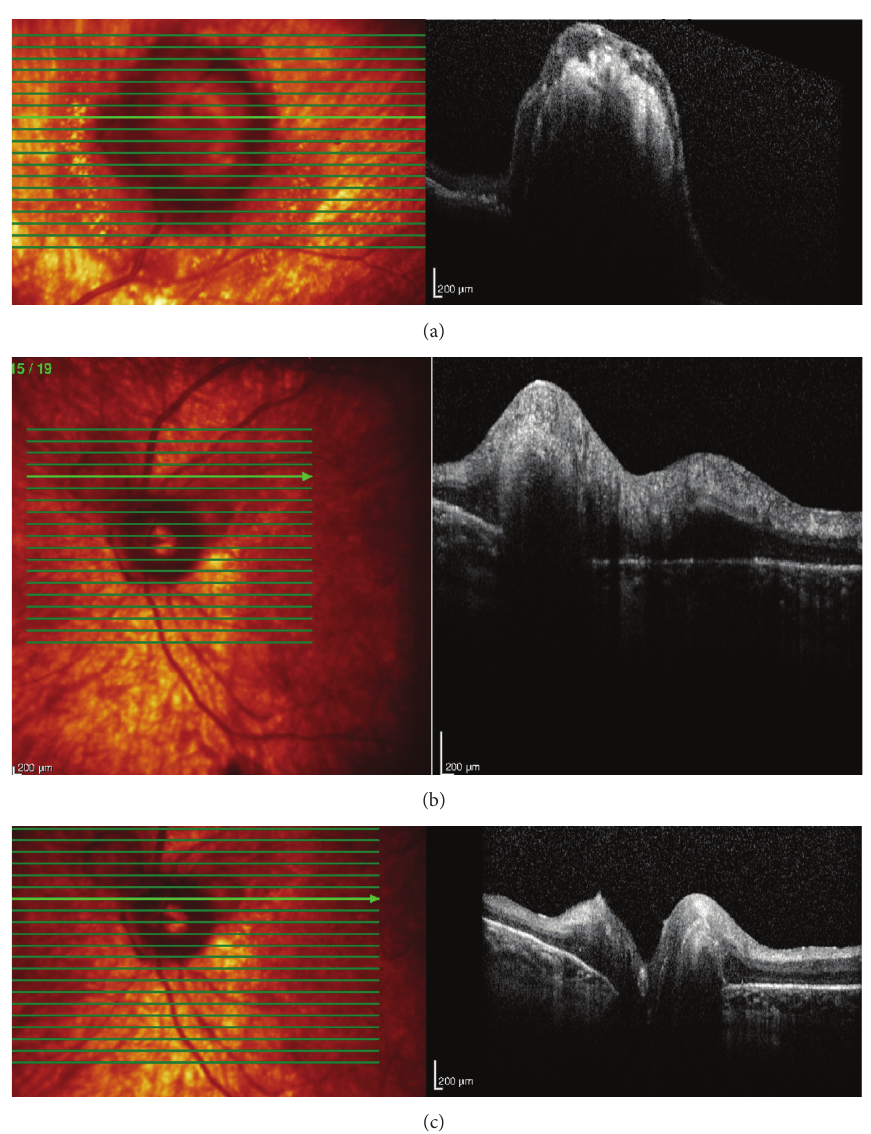
Figure 3: (a–c) Optical coherent tomography (OCT) in LE showed 2 lesions around the optic disc and 1 on the temporal vascular superior arcade. Overlying the dome-shaped elevation of the outer retinal layers, the choroid was thickened and the retinal pigment epithelium (RPE) was